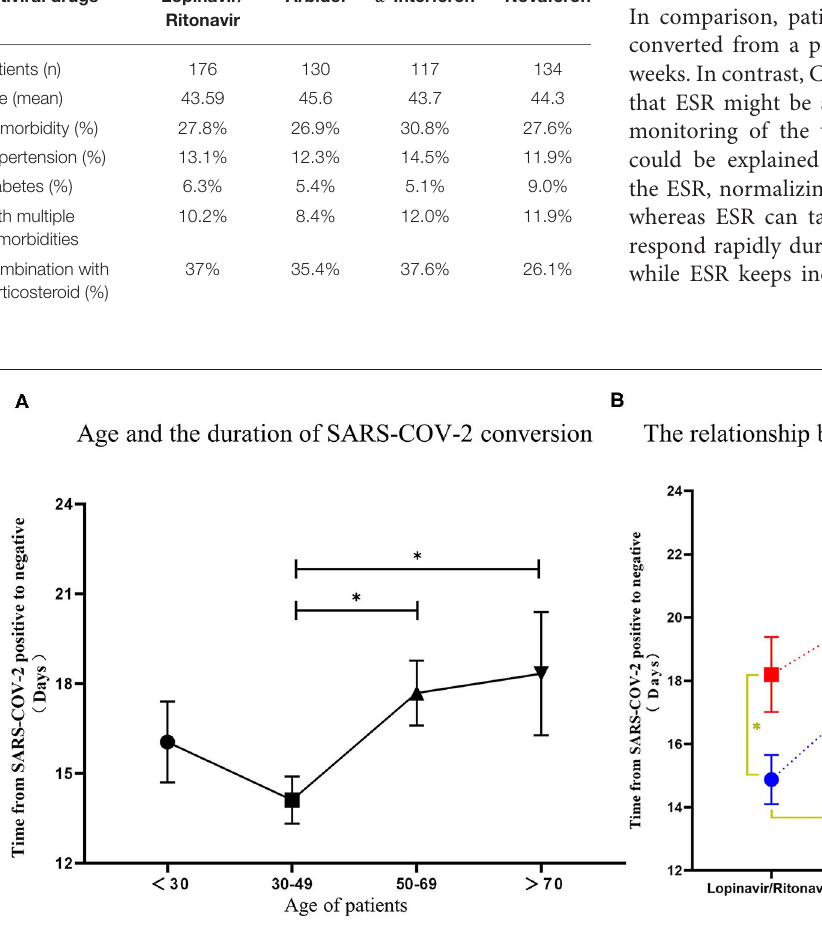
Frontiers in Medicine |